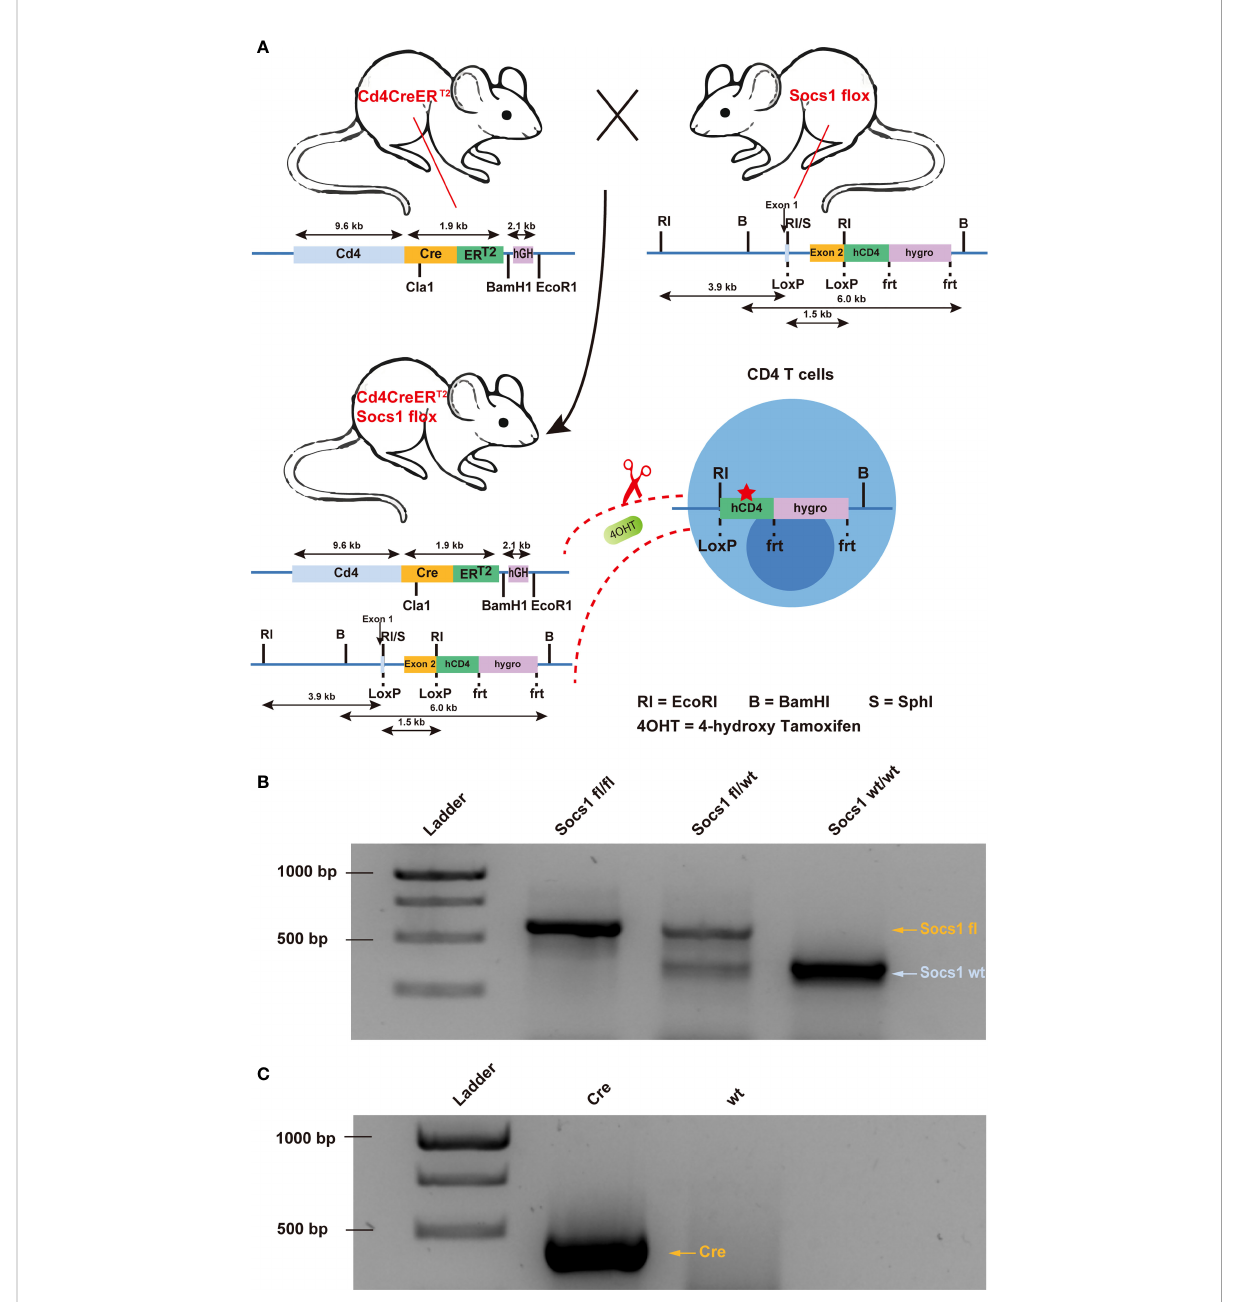
FIGURE 1 Creation of conditional Socs1 knockout mice permitting speci fi c inactivation of the Socs1 gene in CD4 T cells. (A) . Breeding scheme used to create on conditional knockout mice permitting speci fi c deletion of functional Socs1 in CD4 T cells. The transgenic Socs1 fl ox Cd4Cre+ (Socs1 fl / wt Cd4Cre+ and Socs1 fl / fl Cd4Cre+) mice were generated by crossing Socs1 fl ox (in which the exon2 of Socs1 is fl anked by LoxP sites) with the inducible Cd4CreERT2 mice (in which Cre is under the control of CD4 promoter. Expression of the Cre recombinase gene is induced in CD4 T cells by giving the mice the drug tamoxifen, (shown in the fi gure as 4OHT). Tamoxifen allows the Cre recombinase to enter the nucleus of CD4 T cells and recombine the loxP sites. In the event that Socs1 fl was deleted by Cre, the inserted reporter human CD4 (hCD4) will be under control of the endogenous Socs1 promoter and expressed instead of Socs1 . The human CD4 reporter contains a F43I mutation and intracellular truncation to abrogates its function. (B) . Agarose gel electrophoresis image of the Socs1 PCR product of Socs1 fl / fl , Socs1 fl /wt and Socs1wt/wt mice. Visible marker bands indicate fragment sizes of 1000, 750, 500 and 250 bps from top to bottom (lane 1). (C) . Agarose gel electrophoresis image of the Cre PCR product of the Cd4Cre+ and wildtype mice. Visible marker bands indicate fragment sizes of 1000, 750 and 500 bps from top to bottom (lane